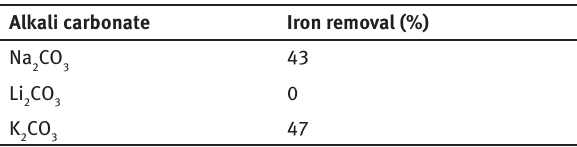
Figure 8: (a) XRPD pattern of ilmenite roasted with KOH and K scattered image of ilmenite roasted with K Table 2: Iron removal percentage after water leaching of ilmenite with alkali carbonates